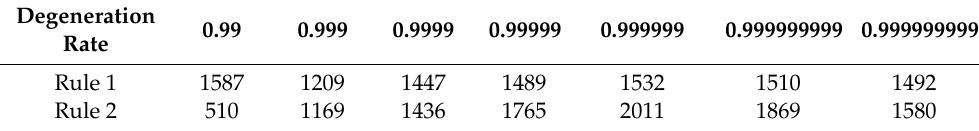
Table 2. Effect of degeneration rate on low-probability password hits (Rules 1 and 2).